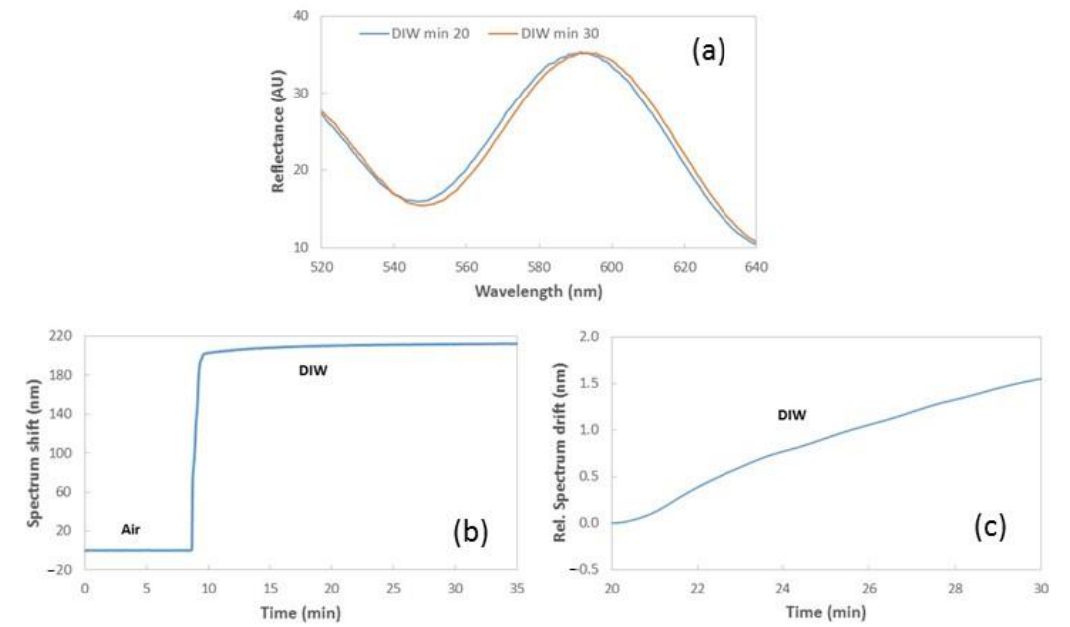
Figure 4. ( a ) Reflectance spectrum of a reference PA6 NFs layer when flowing deionized water (DIW) at two different moments of our sensing test. ( b ) Temporal evolution of the spectrum shift measured for the NFs layer in real-time, when changing from air to DIW flow. ( c ) Relative spectrum drift when flowing DIW between minutes 20 and 30. The peak considered to track the sensor response in ( b , c ) is located around 590 nm.